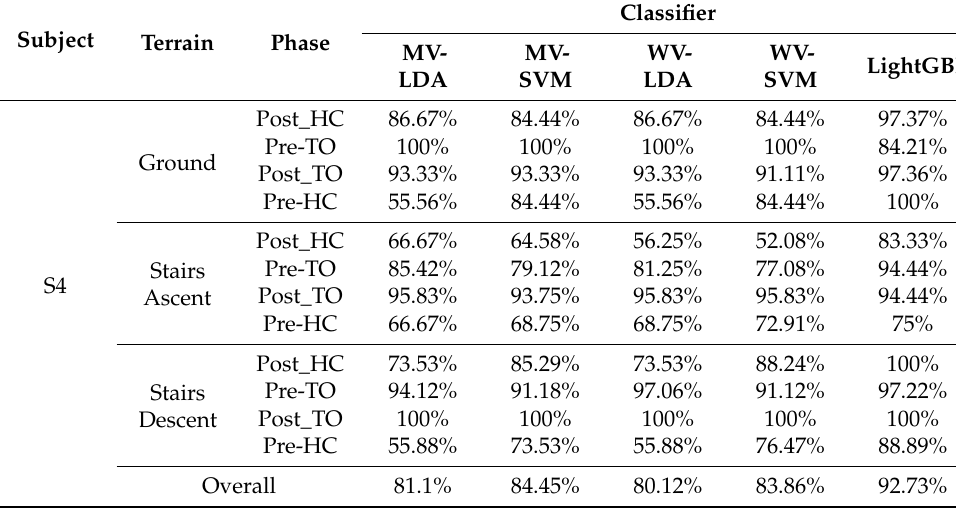
Table 7. Detailed classification performance for the five ensemble learning methods; Subject